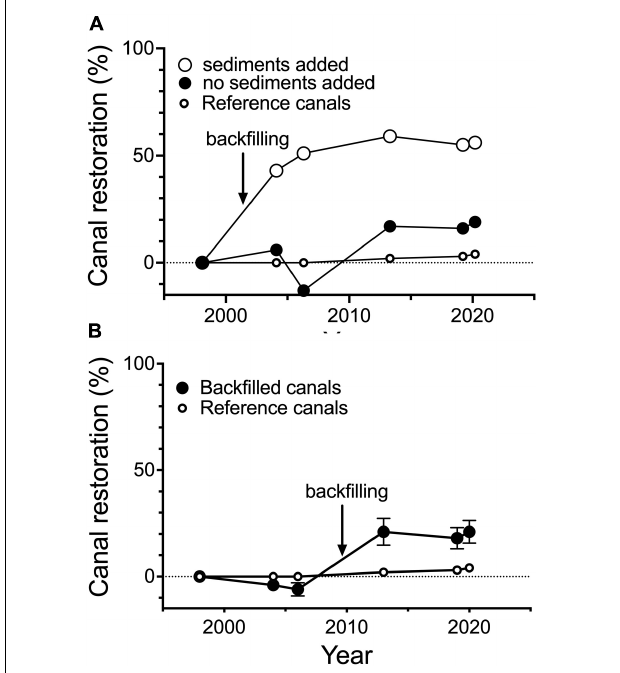
FIGURE 4 | The wetland restoration of the open water of backfilled canals in the Park. (A) Restoration in a single canal backfilled in 2001–2002 and another nearby reference canal that was also backfilled and a sediment slurry was added to fill the canal. (B) Wetland restoration (percent) in canals backfilled in 2010 and nearby reference canals that were not backfilled. The standard error is covered by the